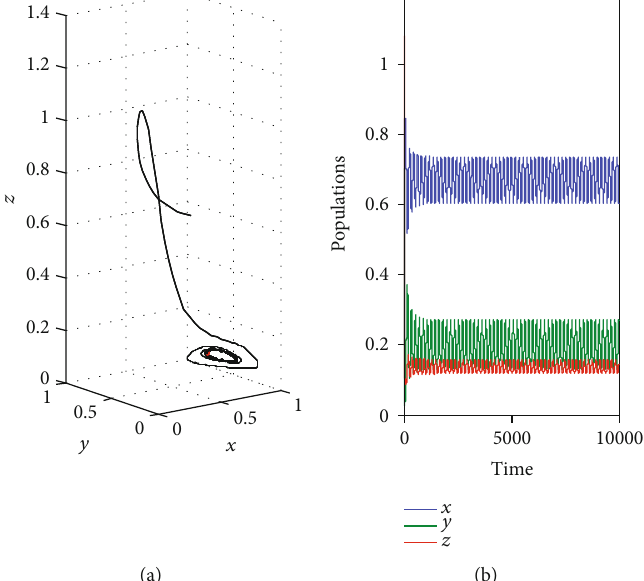
= 20 , with the other 5